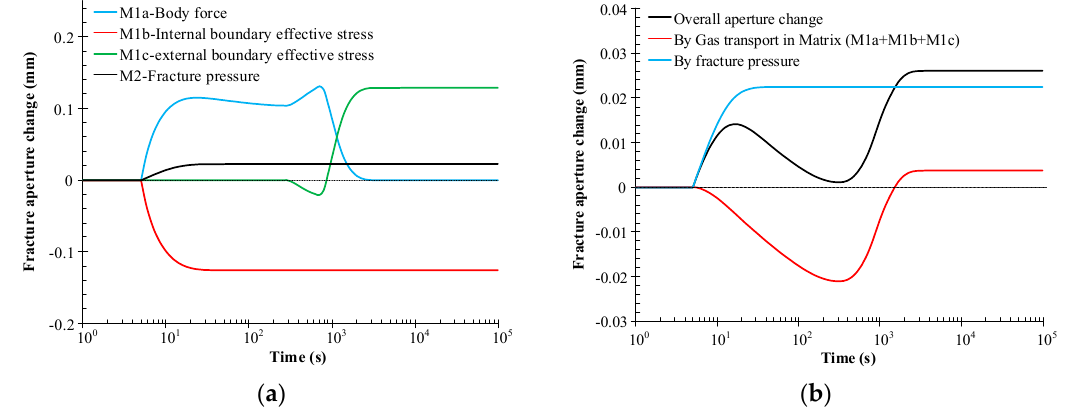
-0.2-0.100.1 Figure 6. Temporal effects of different mechanisms on fracture aperture change. ( a ) Individual effect; ( b ) combined effect. Figure 7. Temporal evolution of the bulk deformation of the representative component geometry. The matrix permeability is also significant in controlling the coupled process and its evolution controls the gas transport behavior during gas transport in the matrix. It is clear that the matrix permeability varies with the change in volume strain, grain compression strain and sorption-induced strain (see Equations (19) and (20)). Figure 9 shows typical volumetric strain and pressure evolution in the matrix domain at Point F, and Figure 10 presents the temporal evolution of permeability ratio for three domain points. As shown in Figure 9, the gas storage increases at Point E when t = 200 s, before which the matrix volumetric strain is influenced by the fracture pressure increase and the gas transport in the propagating zone. After 200 s, the volumetric strain is influenced by the pressure-based sorption-induced strain and grain compaction strain. As a result,